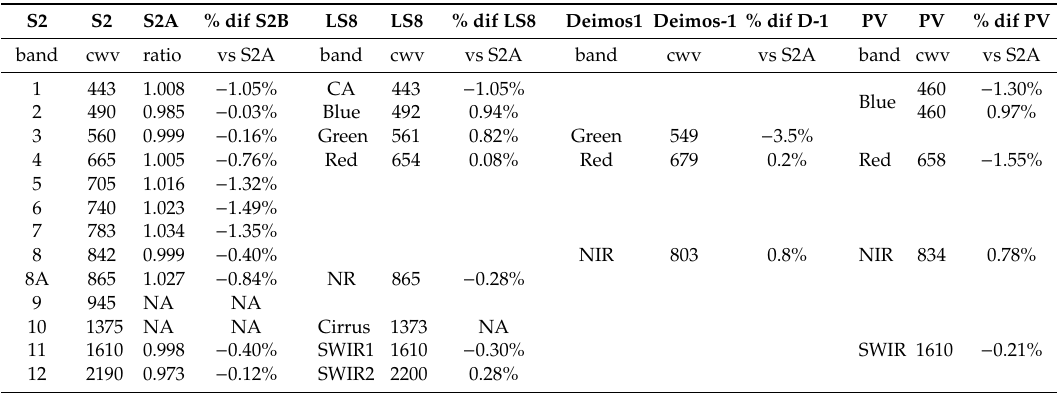
Table 4. Cross-calibration results: Inter-comparison of the mean ratios for spectrally similar bands. The percentage di ff erence of the mean ratios given in Table 3 for the di ff erent sensors to the ratios for Sentinel-2A for spectrally similar bands is provided. Positive values for a certain band indicate that the sensor is brighter than